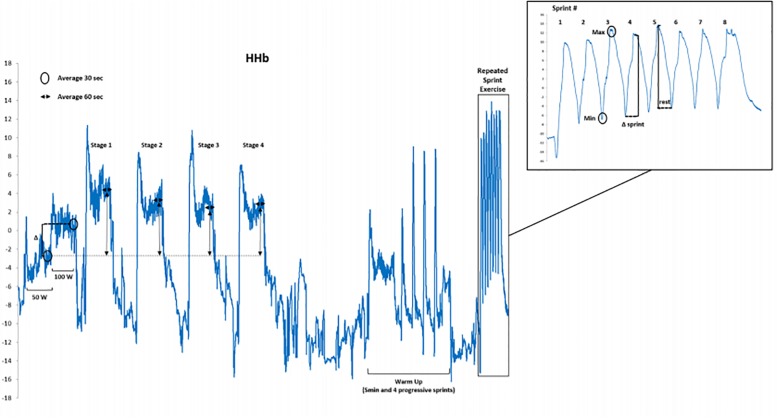
Illustration of the methodology and normalization procedure of NIRS with one subject’s raw signal of deoxygenation (HHb).